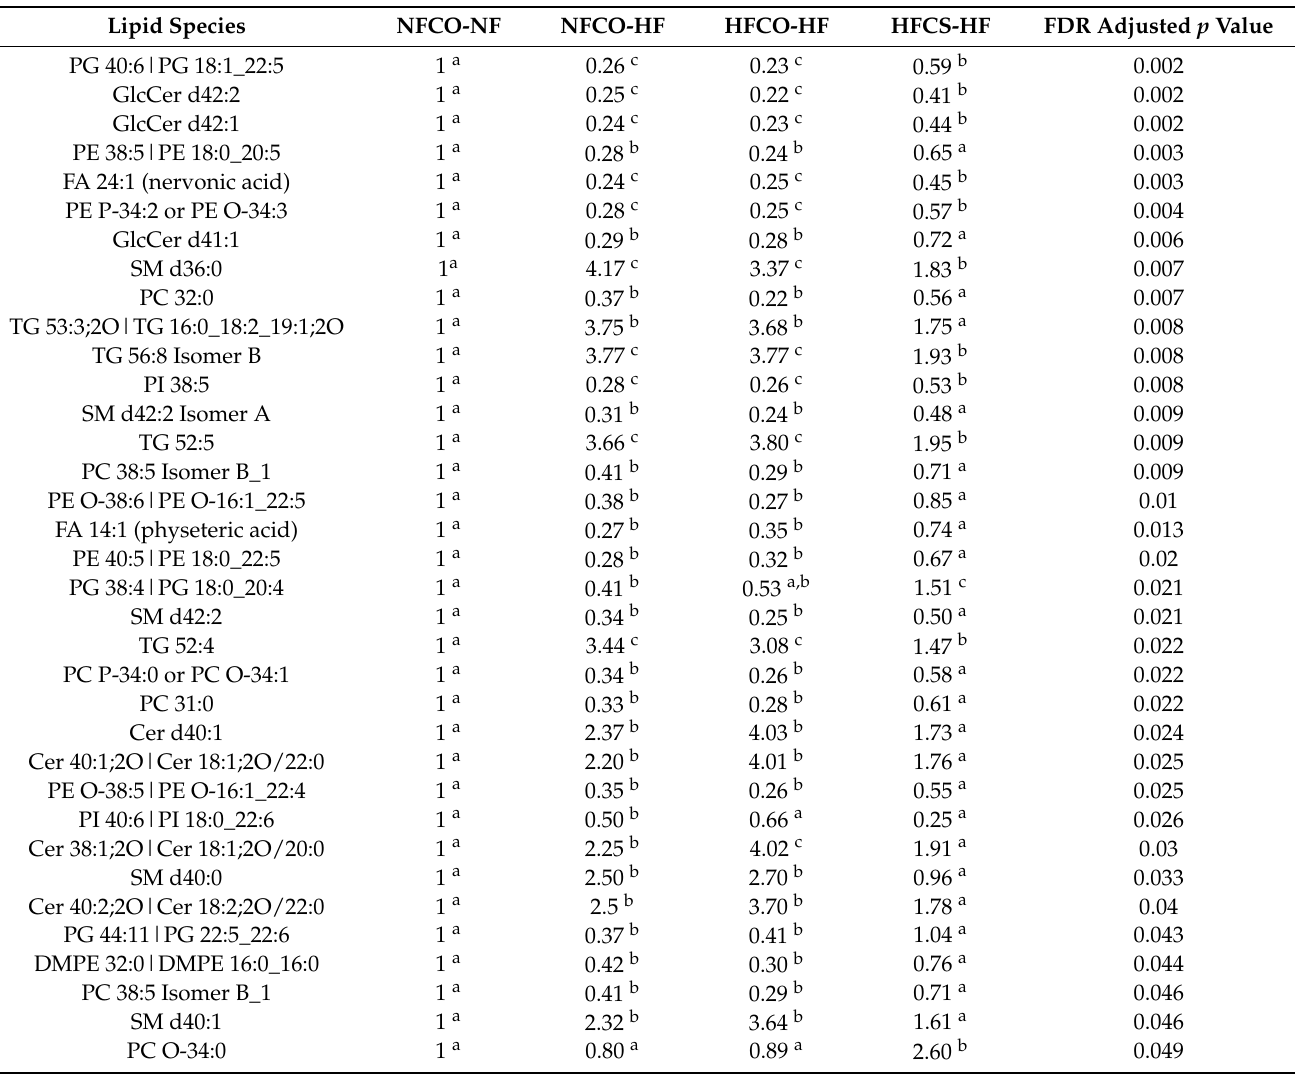
Table 2. Lipid species significantly differed between the maternal HFCS and HFCO offspring after 6-week post-weaning HF